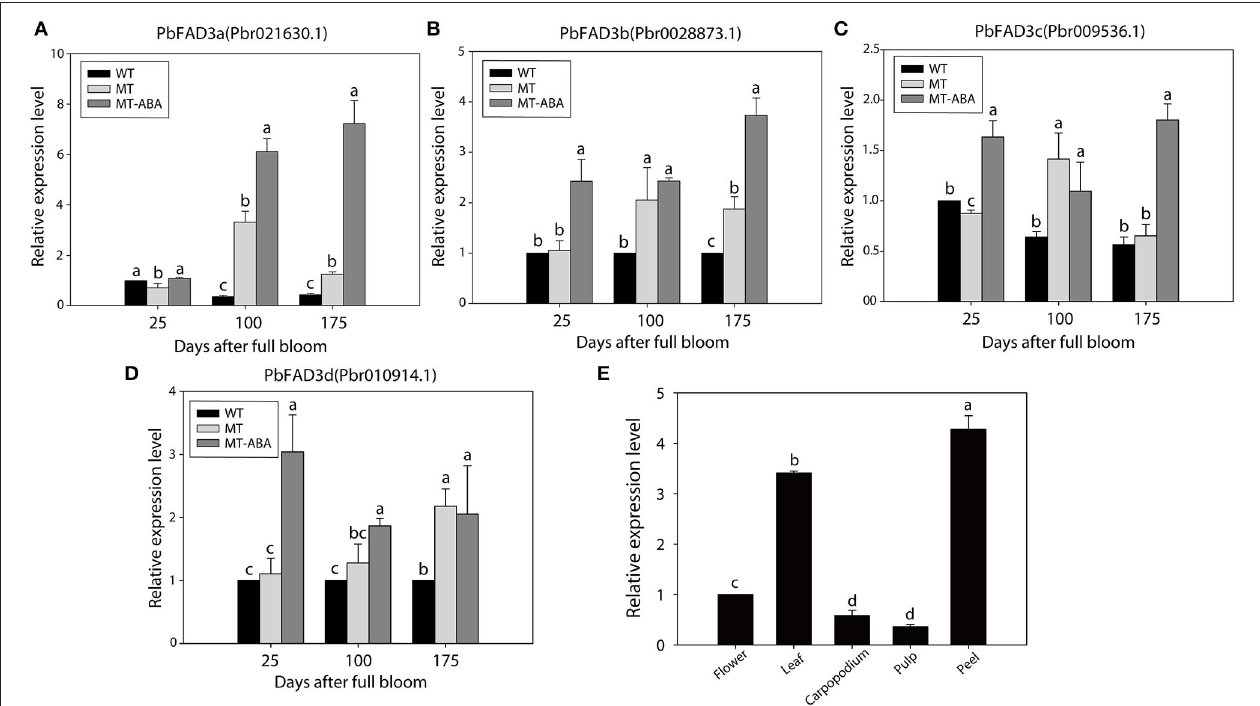
FIGURE 6 | qRT-PCR verification of PbFAD3s . (A–D) Expression analysis of PbFAD3s . (E) Tissue specificity analysis of PbFAD3a . WT, ‘Dangshansuli’; MT, ‘Dangshanjinsu’; MT-ABA, ‘Dangshanjinsu’ treated with exogenous ABA (100 µ M); DAFB, days after full bloom. The error bars are the means ± SD of three biological repeats and lowercase letters indicate significant differences by two-tailed Student’s t -test ( p <